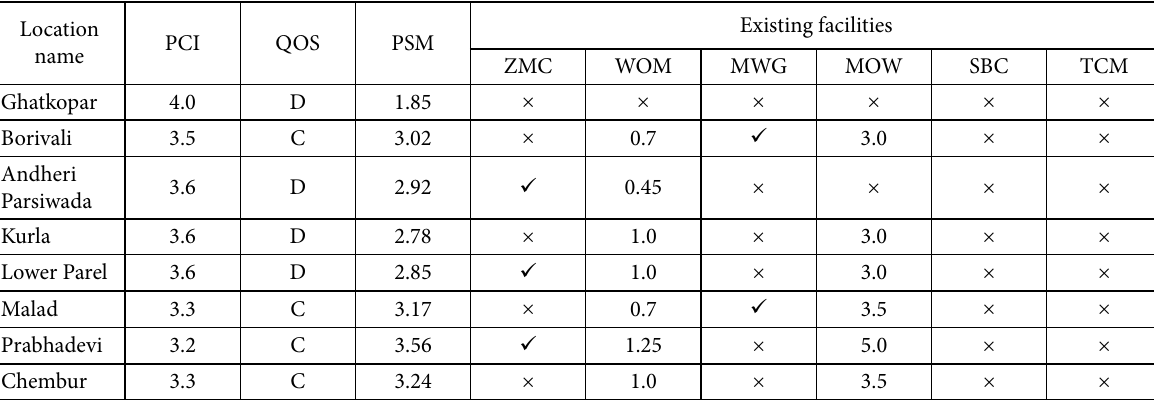
Table 7. Selected Unprotected Crosswalks PCI and